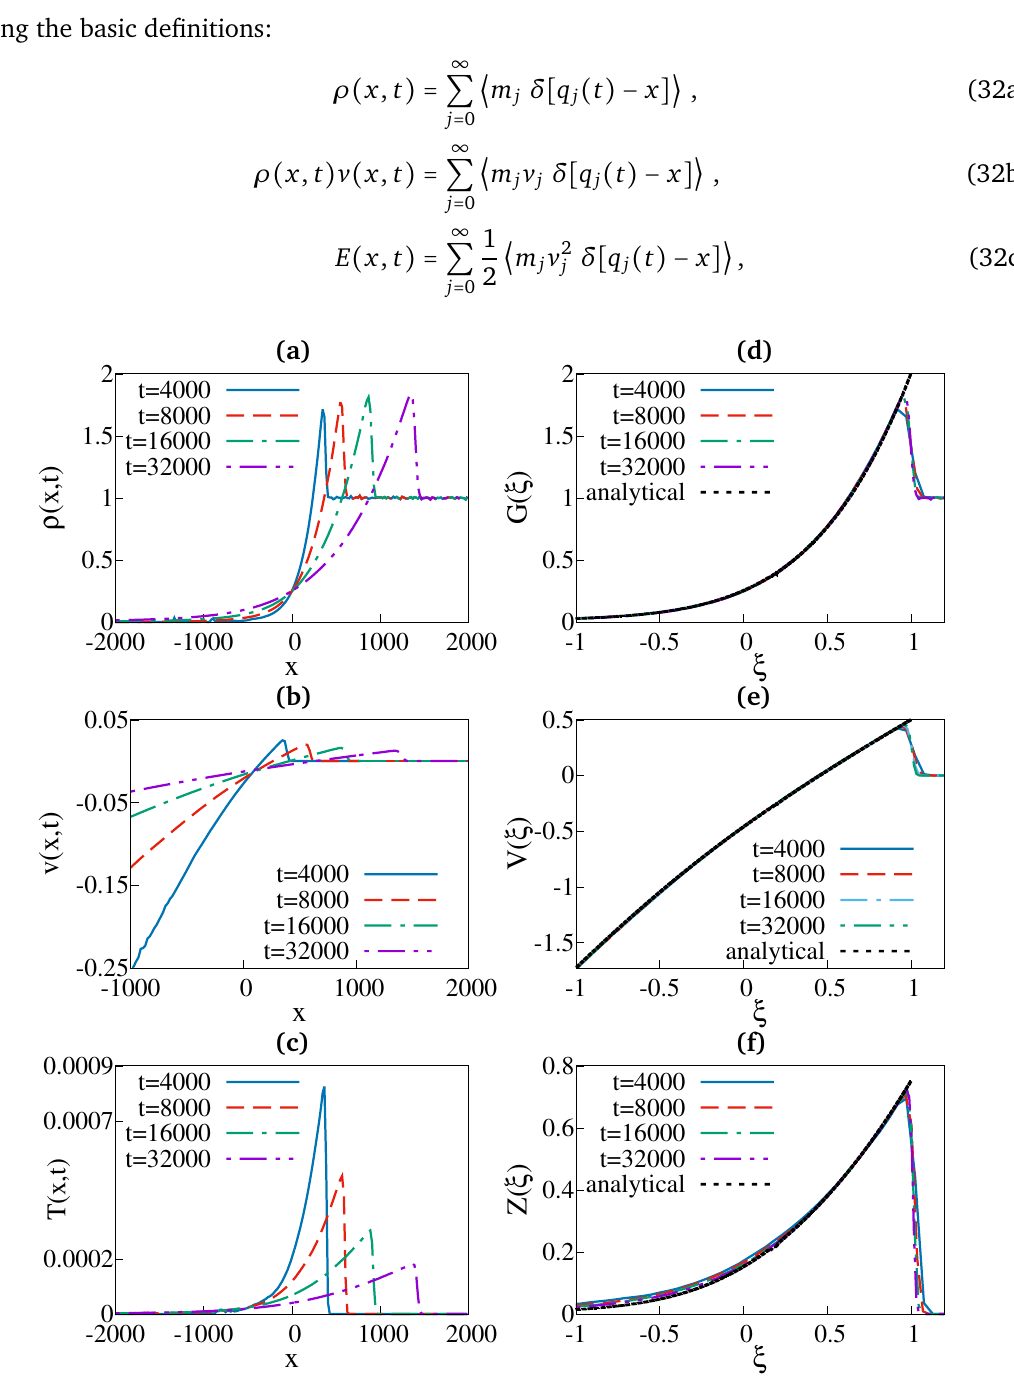
Figure 5: Comparison of microscopic simulation results with analytic predictions for the scaling functions corresponding to the hydrodynamic conserved fields: (a),(b),(c) show plots of the profiles of density, velocity and temperature fields calcu- lated from molecular dynamic simulations, at different times. The simulation param- eters were ρ ∞ = 1, v 0 ( 0 ) = 1, m = 2 / 3, M = 4 / 3, with the mass arrangement (3a), and an ensemble average over 10 5 initial conditions were performed. In (d),(e),(f) we see the scaling collapse of the simulation data and we see an excellent agreement with the analytic scaling functions G ( ξ ) , V ( ξ ) and Z ( ξ ) (black dashed line). The scaling variable was taken as ξ = x / R ( t ) with R ( t ) = 2.08 t δ